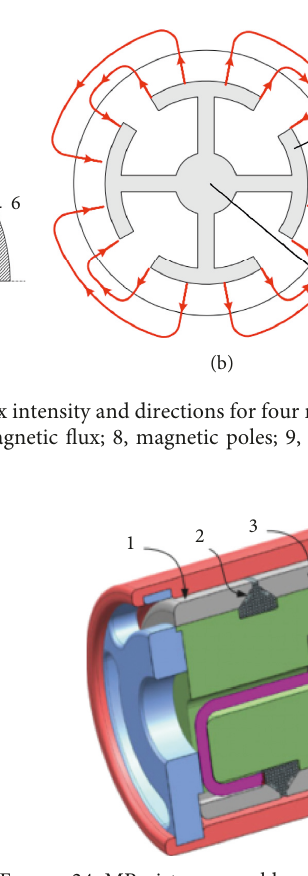
Figure 24: MR piston assembly with a trapezoidal coil: 1, poles; 2, coil; 3, inner core [32,